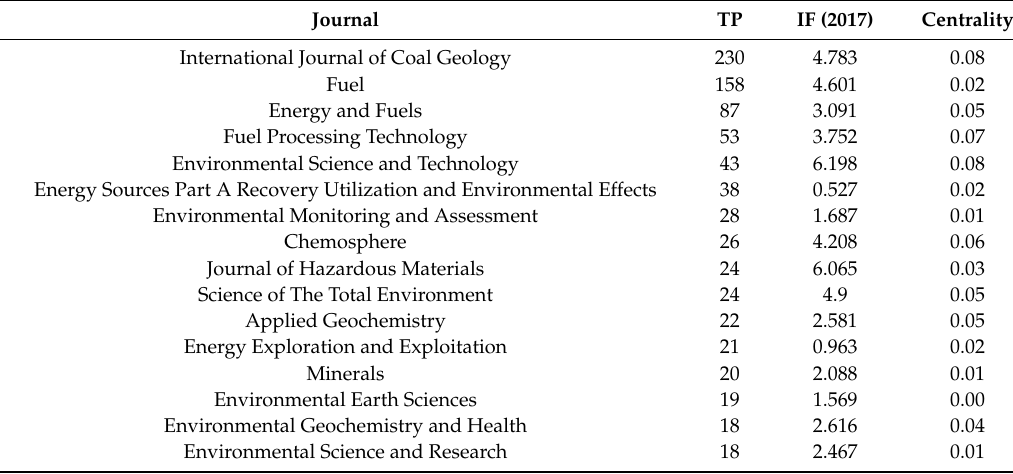
Table 4. Distributions of output in key journals of trace elements in coal and ash in 1971–2017.